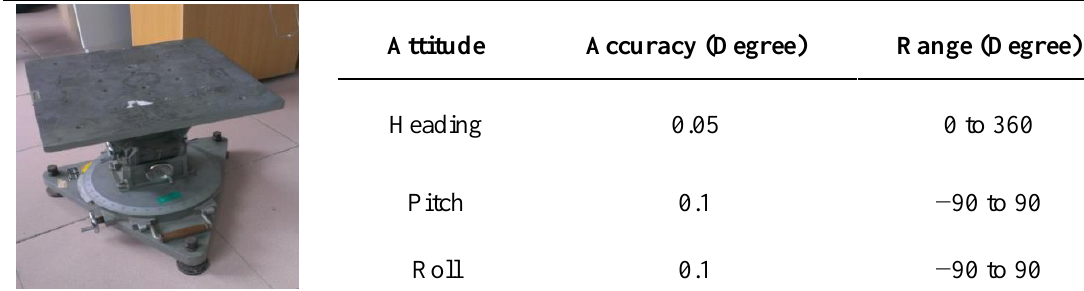
Table 4. The specifications for the three-axis non-magnetic